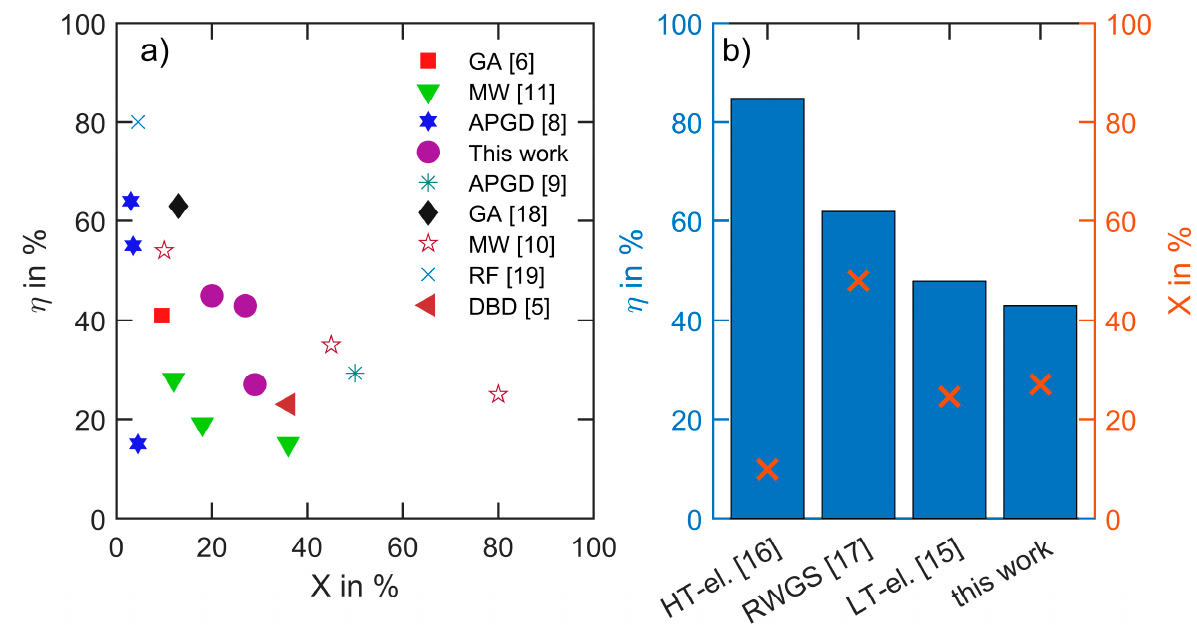
Figure 3. A comparison of the achieved energy efficiency η and conversion X for CO 2 splitting by plasma is shown in ( a ). In ( b ) the results are compared to high temperature electrolysis (HT-el.), low temperature electrolysis (LT-el.) and reverse water gas shift (RWGS).